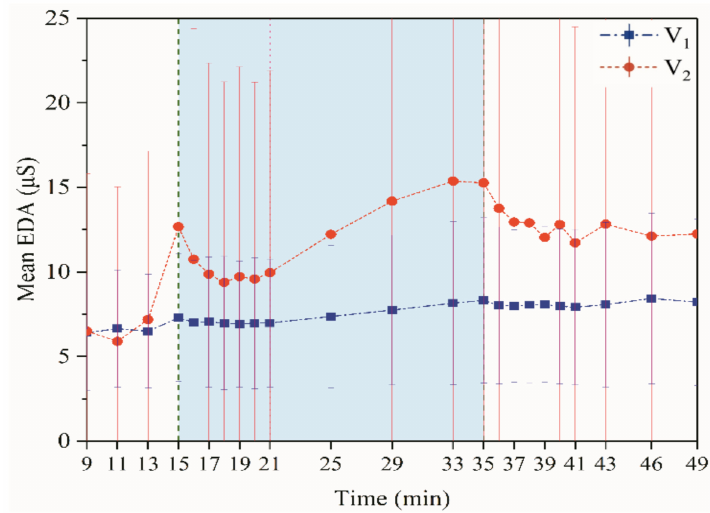
Figure 6. Multiple lines of mean electrodermal activity (EDA) (95% CI) by time and phase.